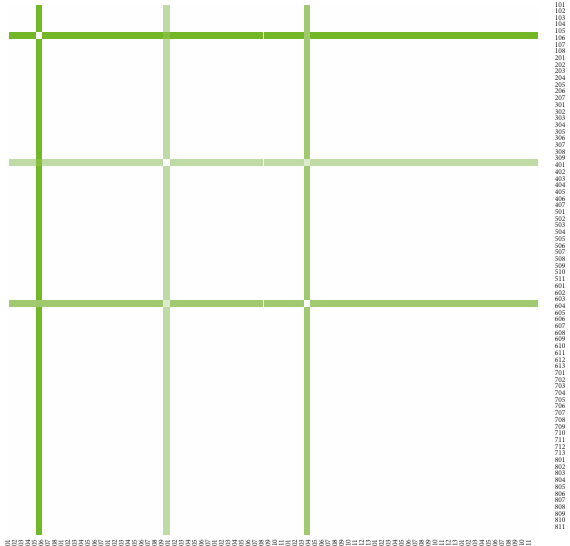
Figure 11: The distance matrix of the similarity of the districts for the female sex in 2000.